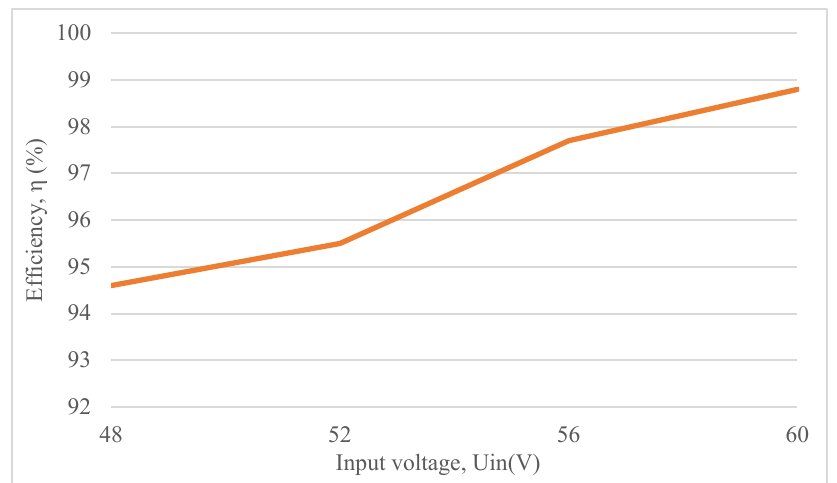
Figure 11. Converter efficiency under different input voltages.